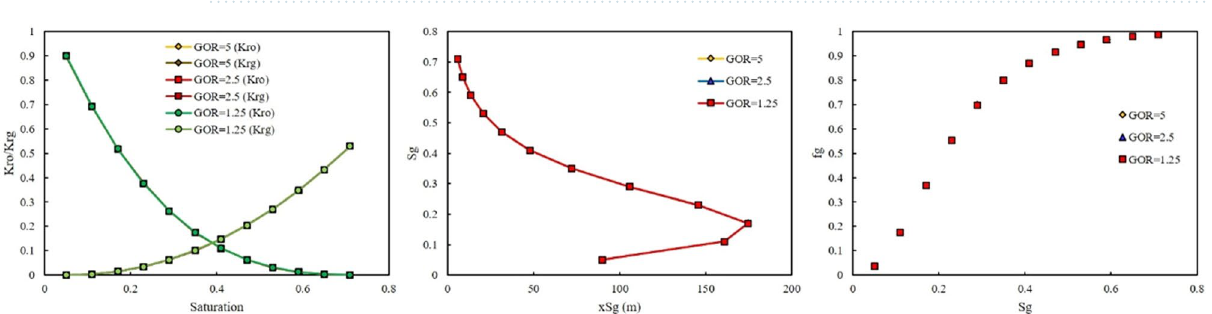
Figure 7. Effect of GOR of LPG on relative permeability, saturation profile, and fractional flow curve at an injection pressure of 3115